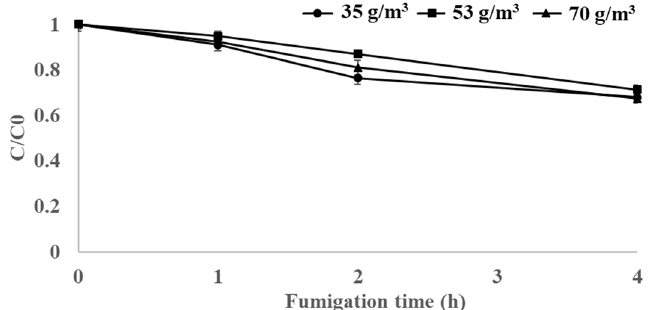
Figure 2. Concentration loss of ethyl formate (EF) (C/C 0 ) in 6.8 L glass fumigation chamber with 70% loading ratio ( w / v ) of imported marble. EF was treated at 35, 53, and 70 g/m 3 for 4 h at 15 °C C = EF concentration determined at one of the time intervals and C 0 = EF concentration at 0.1 h. EF concentration was determined at 0.1, 1.0, 2.0, and 4.0 h after EF had been applied to the fumigation chamber.